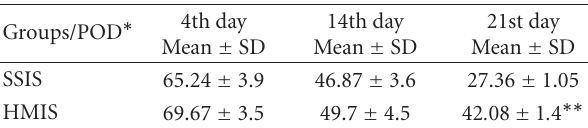
Table 1: The stenosis degree (%) in the serosubmucosal interrupted sutures (SSIS) and horizontal mattress interrupted sutures (HMIS) groups.